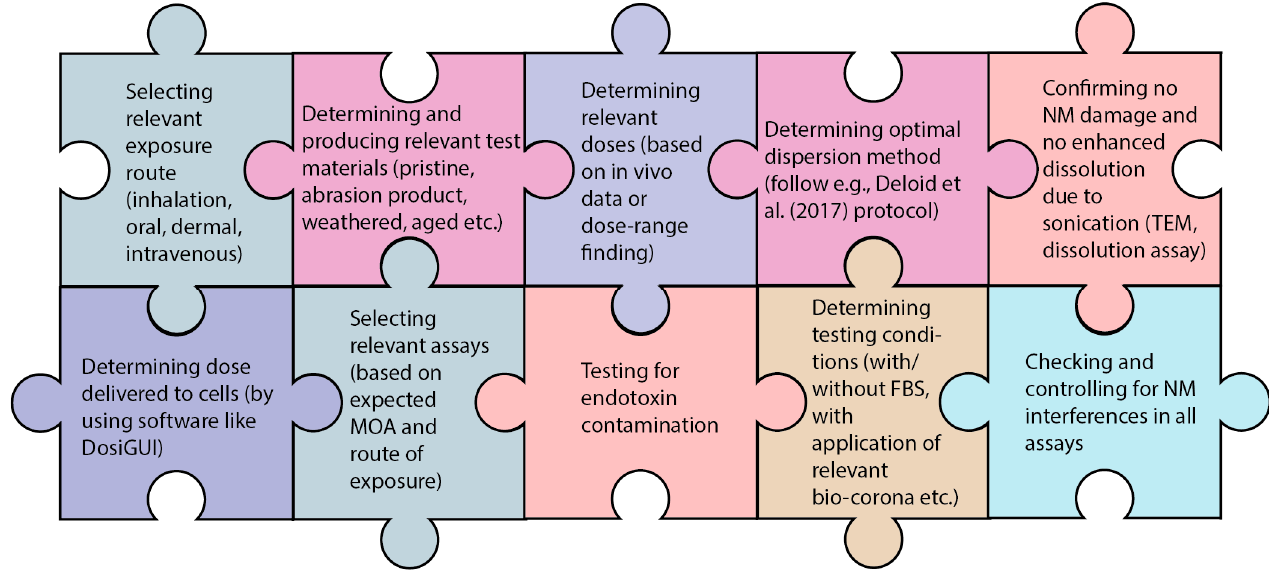
Figure 2. Overview of aspects that might have to be considered when performing SbD hazard testing, showing that simple testing can be challenging to